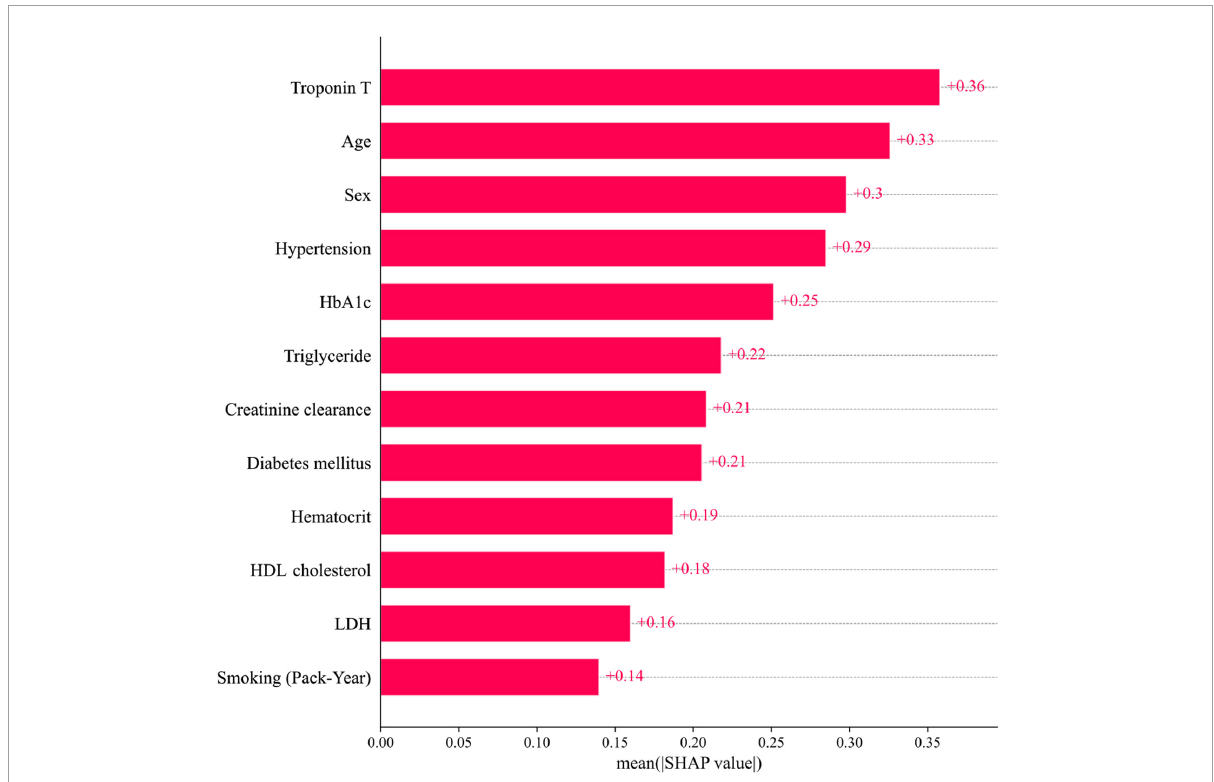
FIGURE3 Feature importance ranking. (A) Mean SHAP value of features. (B) Impact on CatBoost model output of SHAP value. HbA1c, hemoglobin A1c; HDL, high-density lipoprotein; LDH, lactate dehydrogenase; SHAP, SHapley Additive exPlanations; Troponin T, high-sensitivity cardiac troponin